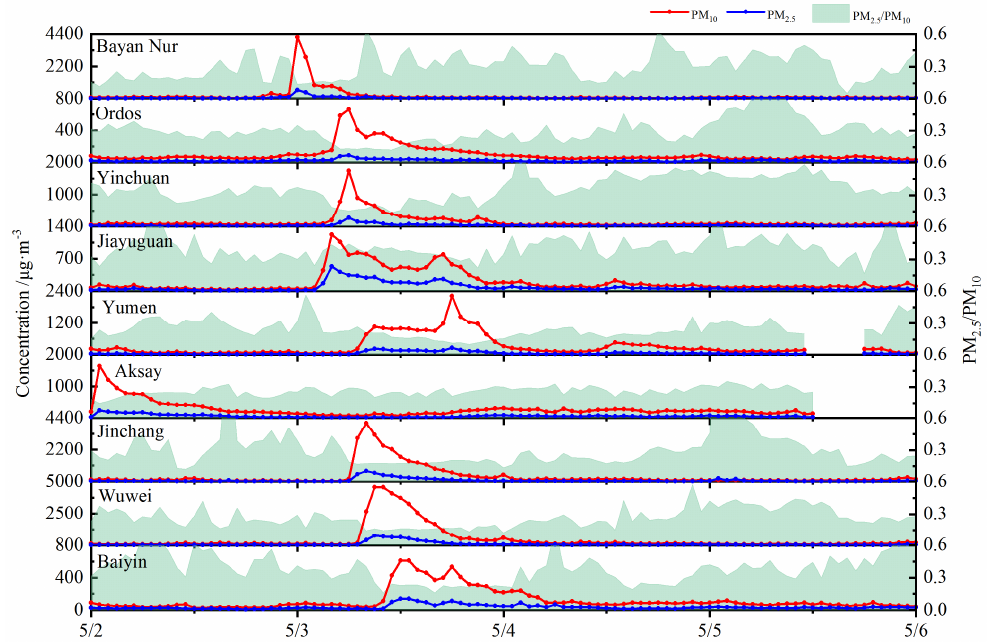
Figure 2. Hourly PM 2.5 and PM 10 concentrations and PM 2.5 /PM 10 from ground observation in cities examined.